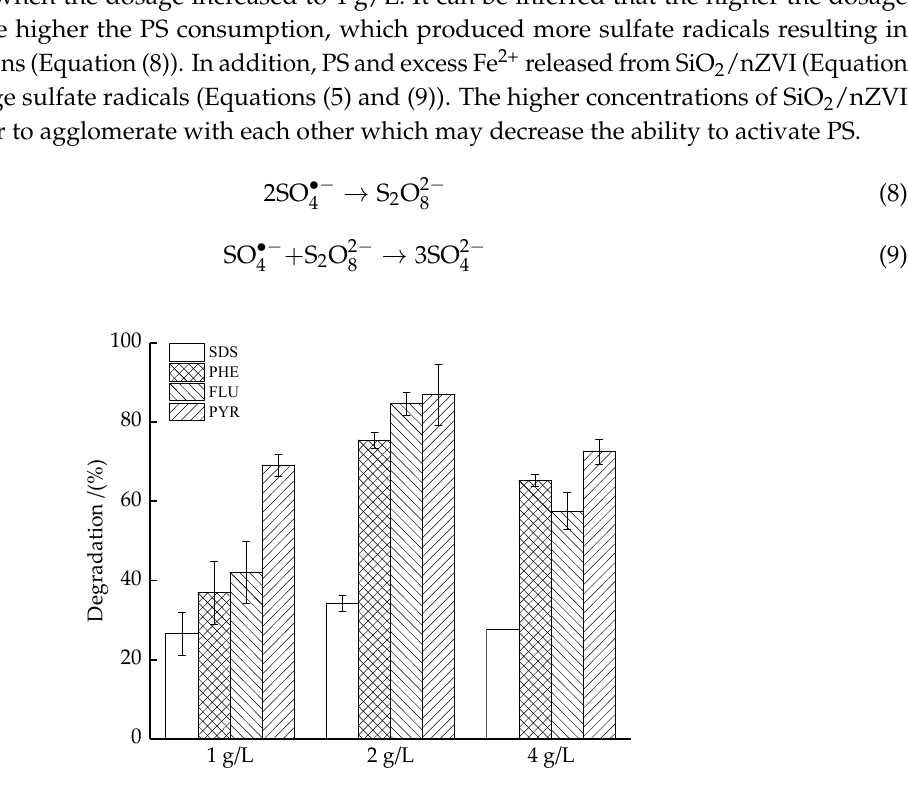
Figure 5. The degradation of PAHs and SDS in soil washing effluents by PS activated with different dosage of SiO 2 /nZVI (1, 2, and 4 g/L). Values are presented as means and standard deviation.